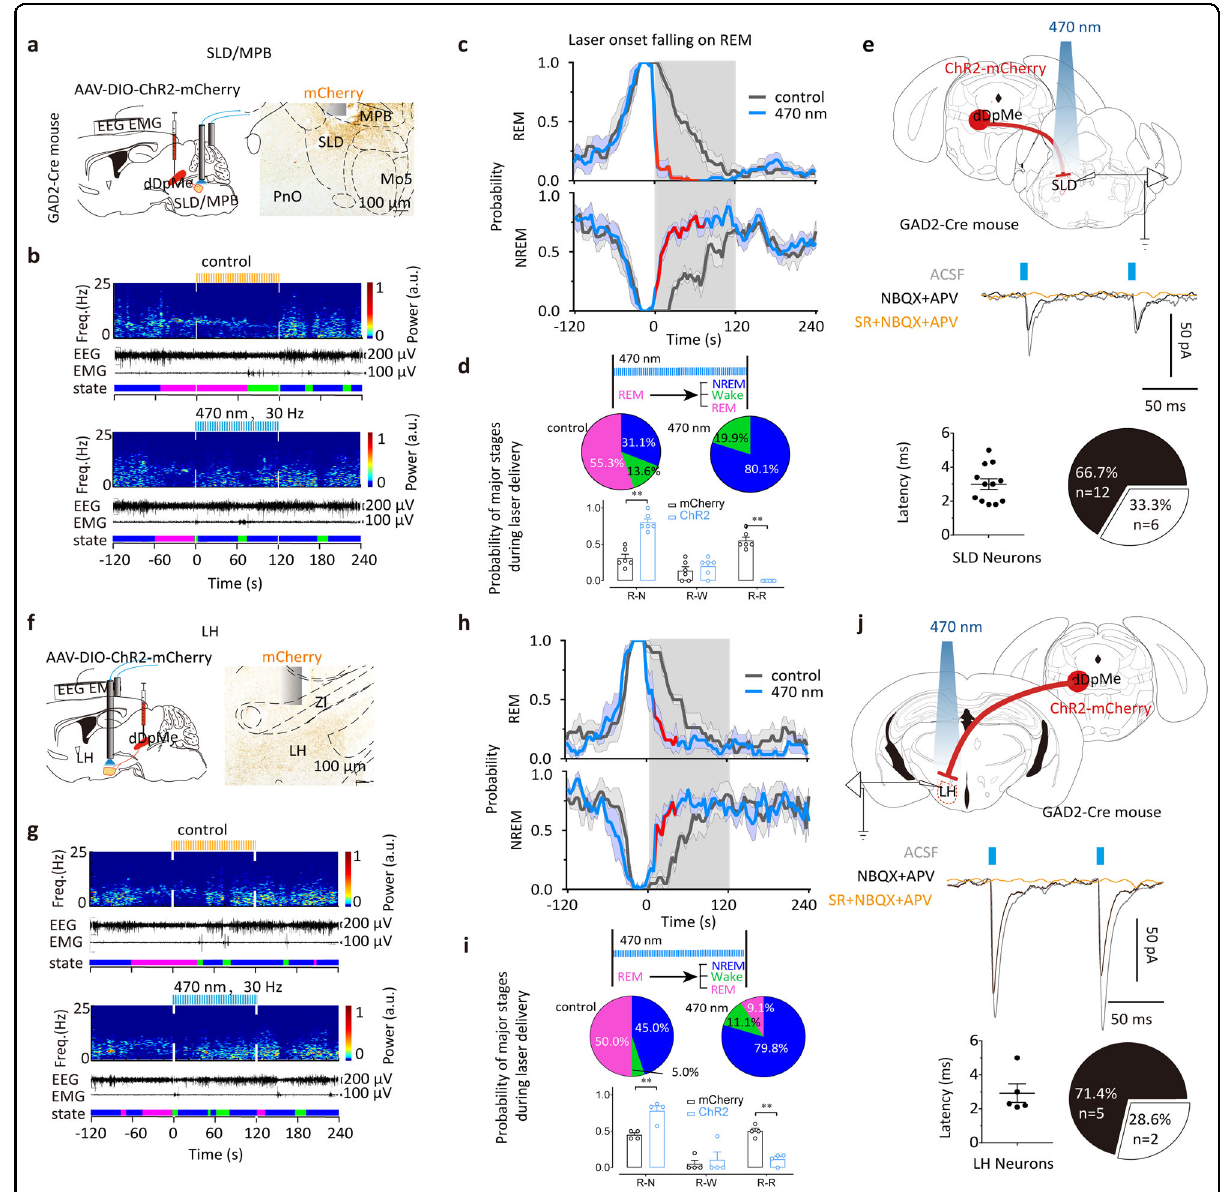
Fig. 3 Activation of dDpMe GABA axonal terminals in the SLD/MPB or LH suppresses REM sleep and promotes REM-to-NREM transitions. Schematic for optogenetic experiments and polygraphic recordings of the dDpMe-SLD/MPB ( a ) and dDpMe-LH pathway ( f ) with dDpMe neurons expressing ChR2-mCherry in GAD2-IRES-Cre mice. Example recordings of EEG power spectrograms, EEG/EMG traces, and hypnograms in GAD2-IRES- Cre mice after bilateral blue-light stimulation (bottom, 470 nm, 30 Hz, 5 ms, 120 s) or yellow-light stimulation (top, 593 nm, 30 Hz, 5 ms, 120 s) of dDpMe GABA axonal terminals in the SLD/MPB ( b ) LH ( g ). Time courses of REM sleep (top) or NREM sleep (bottom) in GAD2-Cre mice after 593-nm or 470-nm laser stimulation of axonal terminals in the dDpMe or ChR2-mCherry-expressing neurons in the SLD/MPB ( c ), LH ( h ) initiated from REM sleep. The red lines indicate a signi fi cant difference ( P < 0.05) compared to the control group, as assessed by two-way ANOVA (posthoc Sidak ’ s multiple comparison tests). F (1,728)(REM) = 149.7, P < 0.001; F (1,728)(NREM) = 123.8, P < 0.001; F (1,728)(wake) = 0.69, P = 0.41 (c). F (1,542)(REM) = 65.22, P < 0.001; F (1,542)(NREM) = 10.98, P < 0.001; F (1,524)(wake) = 25.43, P < 0.001(h). Pie charts and histograms showing major states during laser stimulation initiated from REM sleep ( d ) ChR2-dDpMe-SLD, n = 6; ChR2-dDpMe-LH ( i ), n = 4. Diagram showing the injection of AAV-ChR2 into the dDpMe of GAD2-Cre mice, and the response recorded in the SLD ( e ) or LH ( j ). Photo-stimulation (5 ms) evoked IPSCs in an SLD neuron, which was abolished by SR 95531 (a GABA A antagonist). The latency of photo-stimulation-evoked IPSCs was counted from 12 responded SLD neurons in four mice ( e ) or 5 responded LH neurons in three mice ( j ). The mean latency of SLD neurons responding to the laser was 2.99 ± 0.31 ms ( e ) and that of LH neurons was 2.92 ± 0.54 ms ( j ). Number and proportion of recorded SLD or LH neurons showing a positive or negative response to the photo-stimulation of dDpMe neural terminals. Data represent means ± SEM. * P < 0.05, ** P < 0.01. PnO oral part of pontine reticular nucleus, Mo5 motor trigeminal nucleus, ZI zona